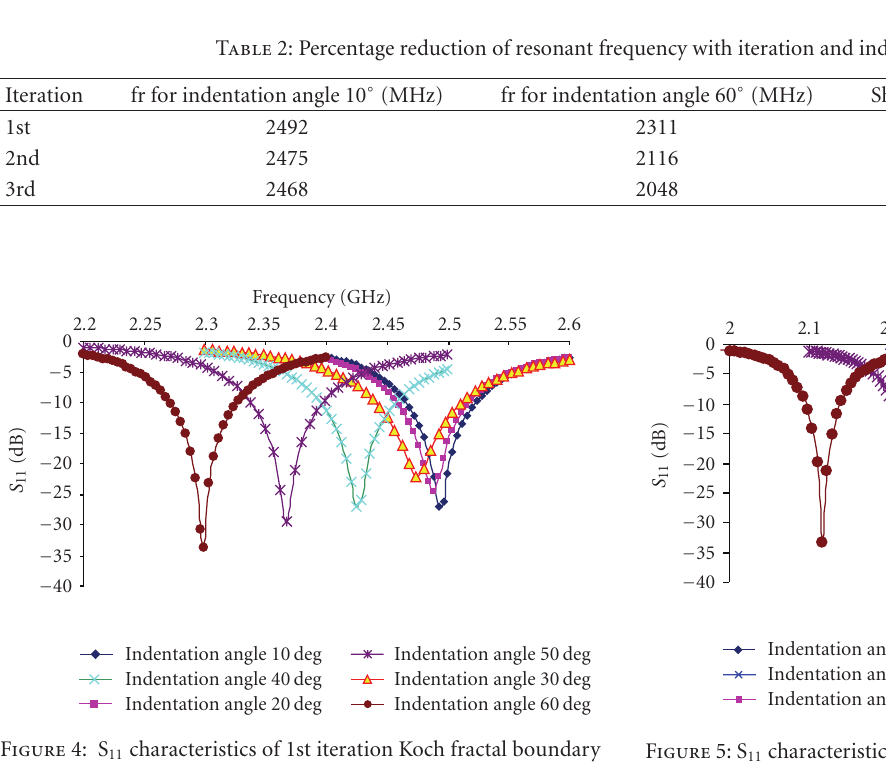
Figure 5: S 11 characteristics of 2nd iteration Koch fractal boundary microstrip antennas with di ff erent indentation angles.